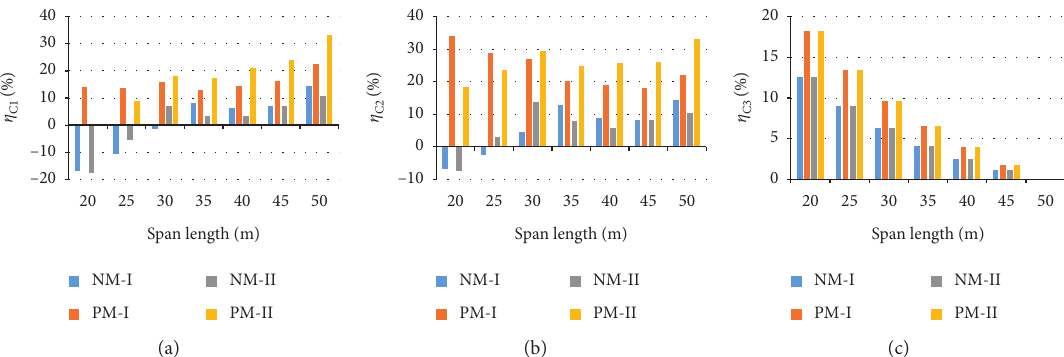
Figure 8: Comparison of the traffic loading effects of three-span continuous girder bridges without the dynamic load allowance: (a) η (b) η C2 ; (c) η C3